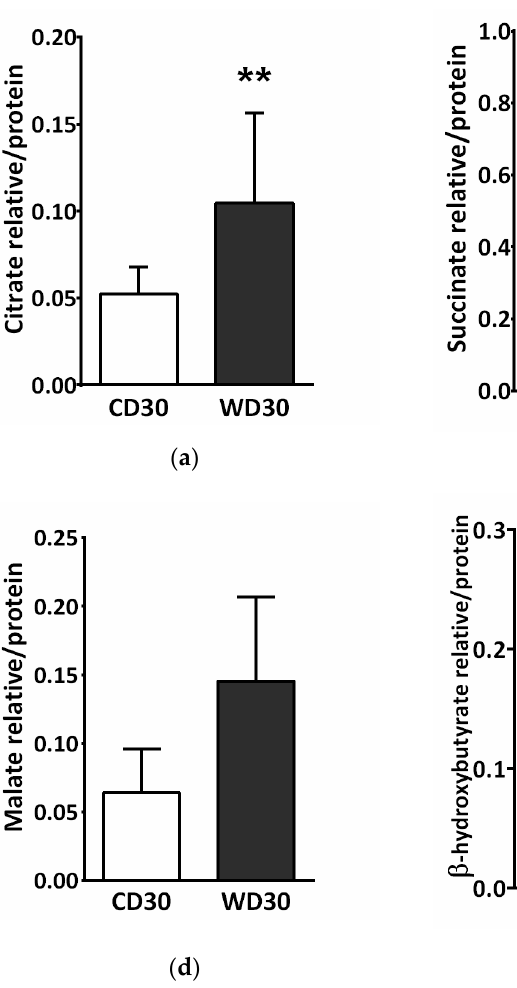
Figure 8. Liver metabolomic analysis in mice fed a control diet (CD30) or a Western-style diet (WD30) for 30 weeks. ( a ) Relative level of citrate. ( b ) Relative level of succinate. ( c ) Relative level of fumarate. ( d ) Relative level of malate. ( e ) Relative level of β -hydroxybutyrate. ( f ) Relative level of lactate. Results are expressed as the means ± SD; * p < 0.05, ** p < 0.01 (n = 6 each group).